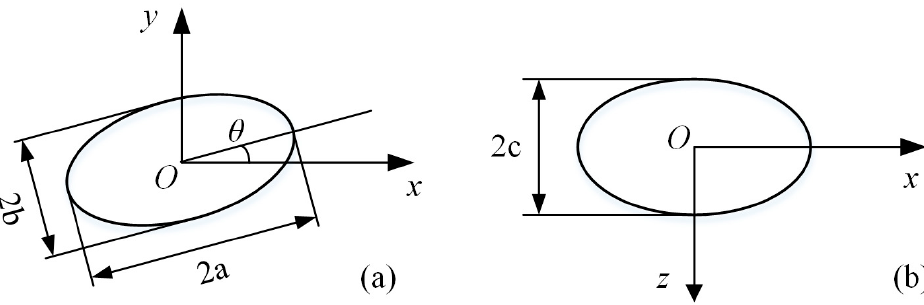
Figure 3. Schematic diagram of droplet geometry model parameters in the ( a ) flow plane and ( b ) rotational plane.